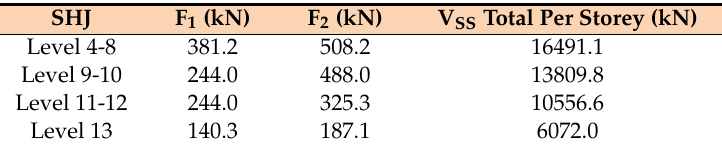
Table 2. Shear sliding capacity contribution breakdown.